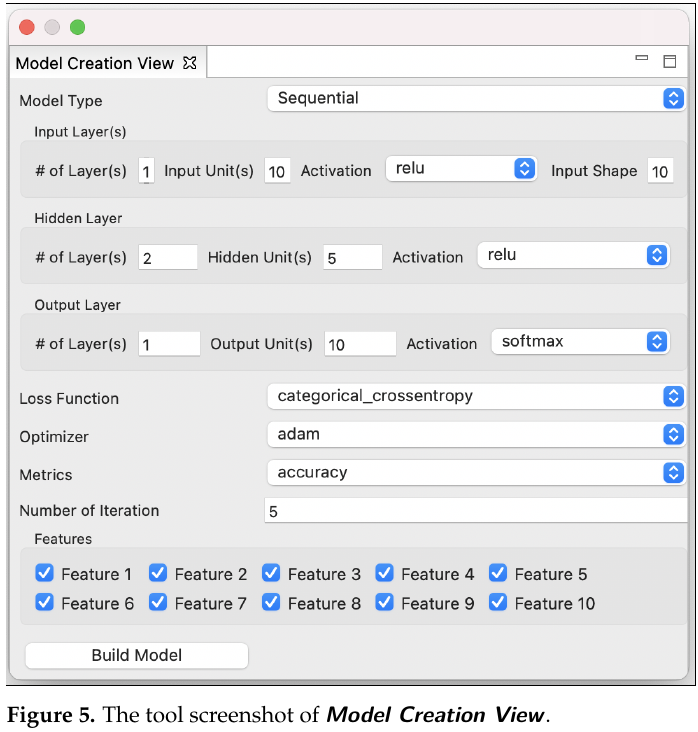
Figure 5. The tool screenshot of Model Creation View .